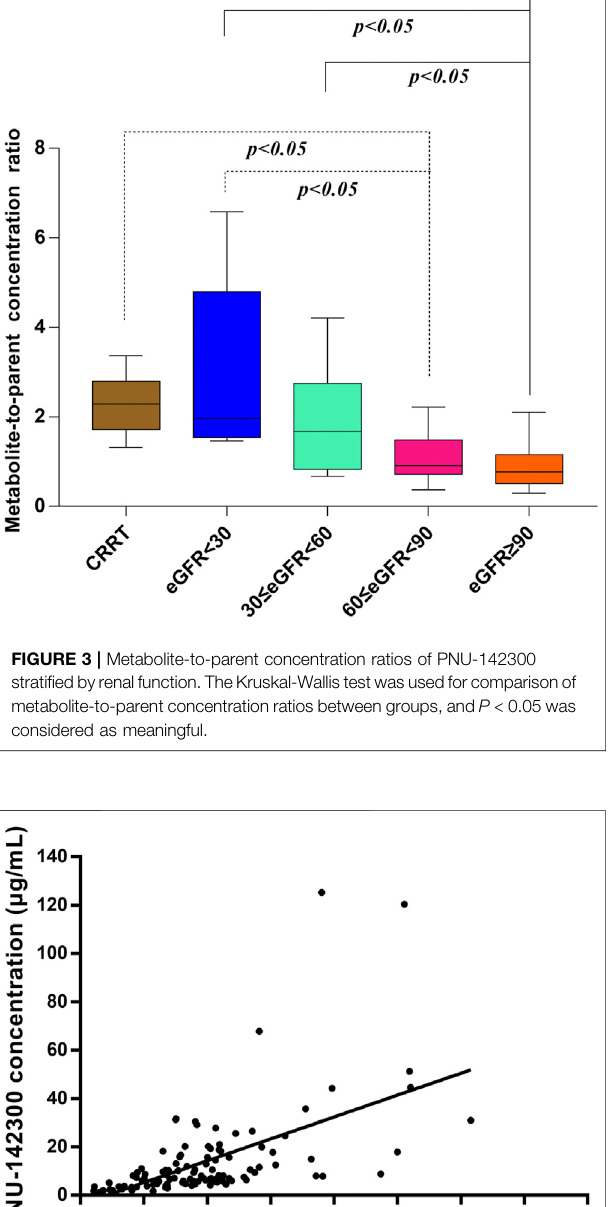
curve of metabolite-to-parent concentration ratios for linezolid-associated myelosuppression was performed in Figure 5 , and the results showed that the ratio higher than 1.31 was identi fi ed as a risk factor.